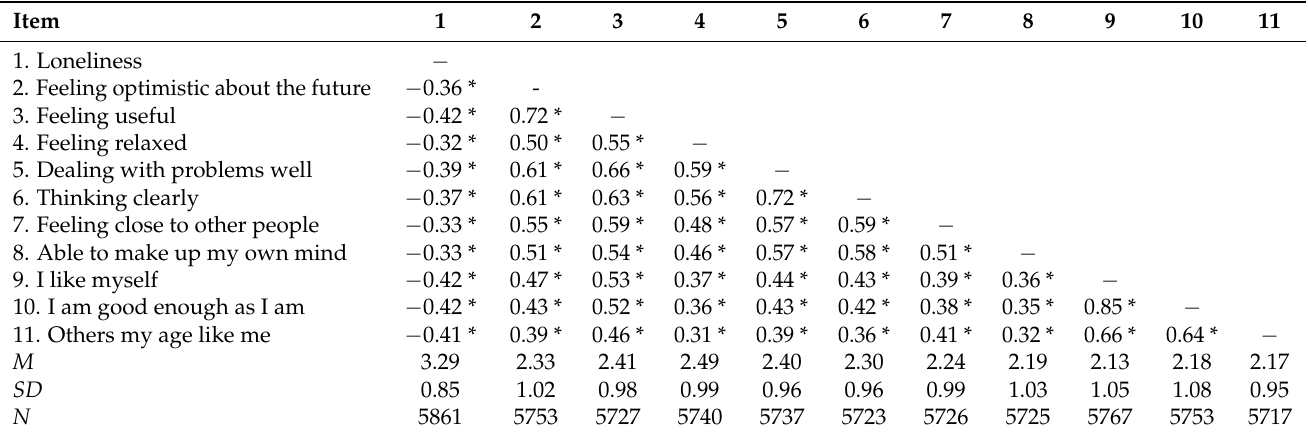
Table 3. Pearson correlations between mental health indicators (mental wellbeing: items 1–7; self-esteem: items 8–10; loneliness: item 11) applied in the present study.